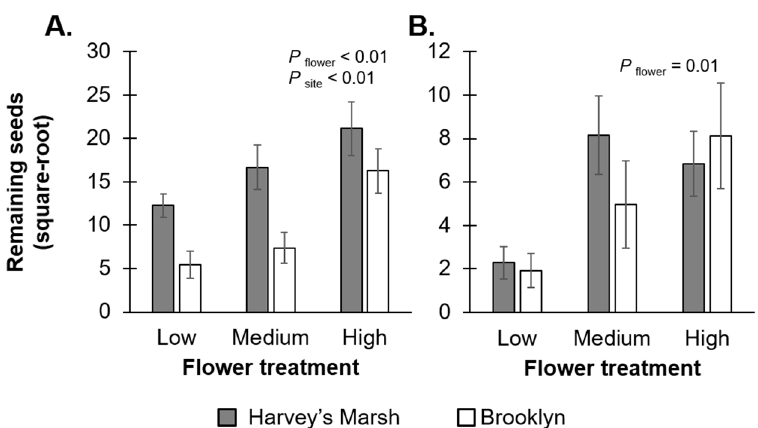
Figure 3. Flower treatment and site comparisons on the overall number of seeds remaining after the pollination and seed predation experiments on Verbena stricta ( A ) and Rudbeckia triloba ( B ). Grey bars represent rates at Harvey’s Marsh (a low resource density site); white bars represent rates at Brooklyn (a high resource density site). Error bars represent ±1 SE. Remaining seed numbers were square-root transformed.